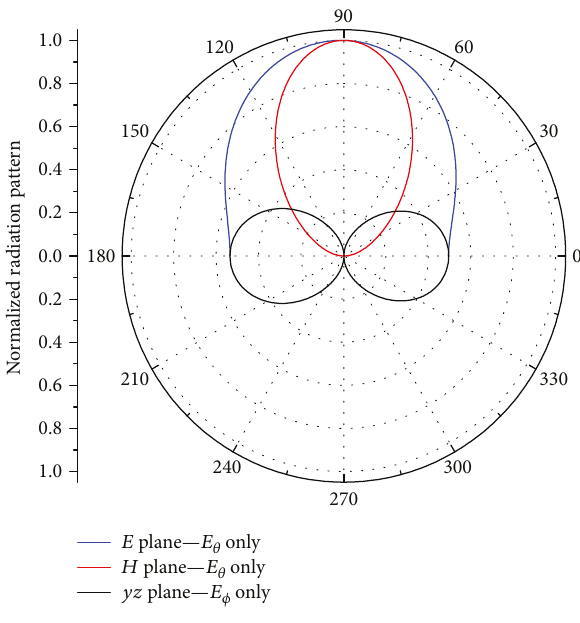
Figure 6: Normalized radiation pattern of the HB